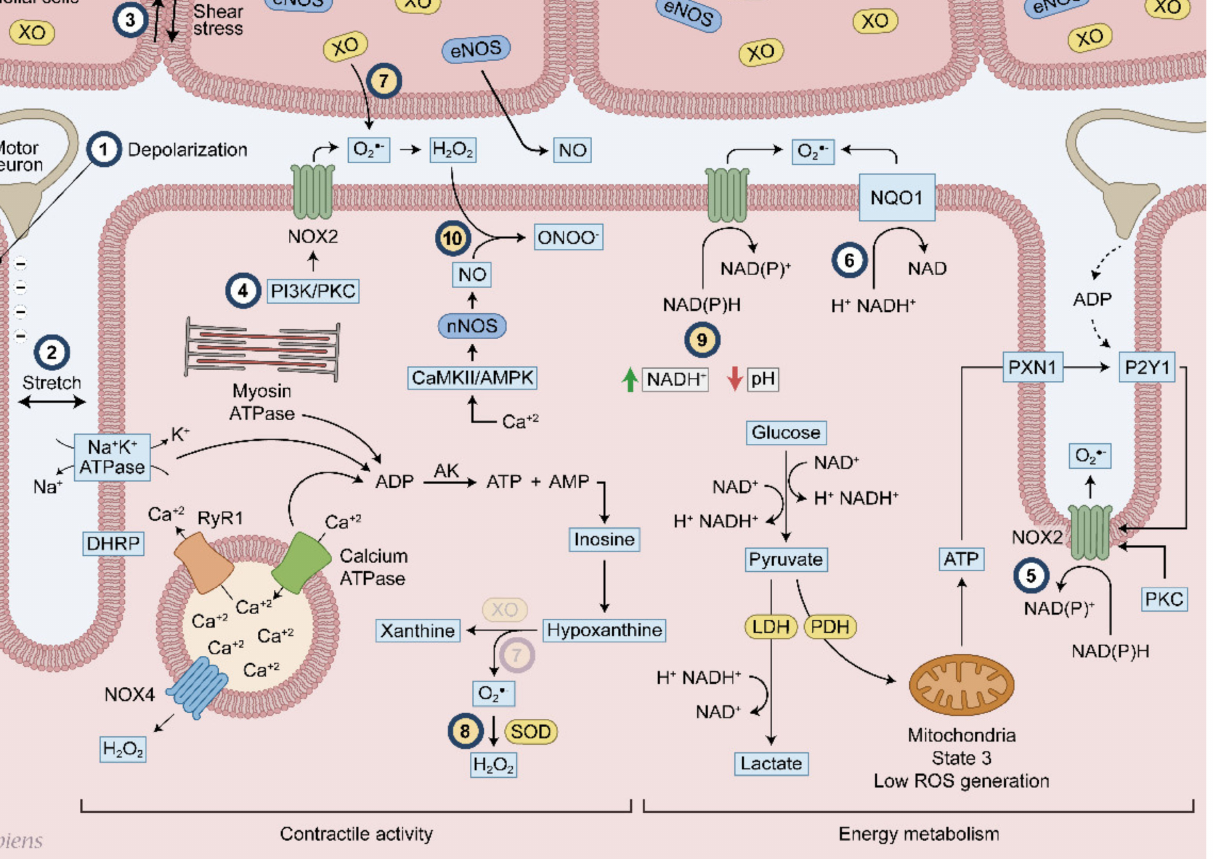
Figure 1. Overview of the mechanisms of reactive oxygen species (ROS) generation following exercise. Multiple mechanisms related to ROS generation in skeletal muscle during contraction. #1 membrane depolarization, #2 stretch #3 shear stress, #4 PI3K/PKC, #5 ATP/P2Y1, #6 NQO1 #7 XO, #8 SOD, #9 NADH/pH and #10 CaMK/AMPK. Numbers from 1 to 6 (#1–6) indicate signaling pathways already established. Numbers from 7 to 10 (#7–10) show hypothetical pathways. #7-The presence of XO in skeletal muscle is still a debated